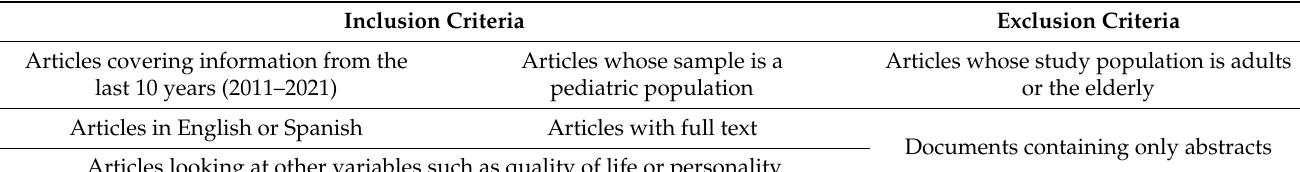
Table 1. Criteria of inclusion and exclusion (own elaboration).